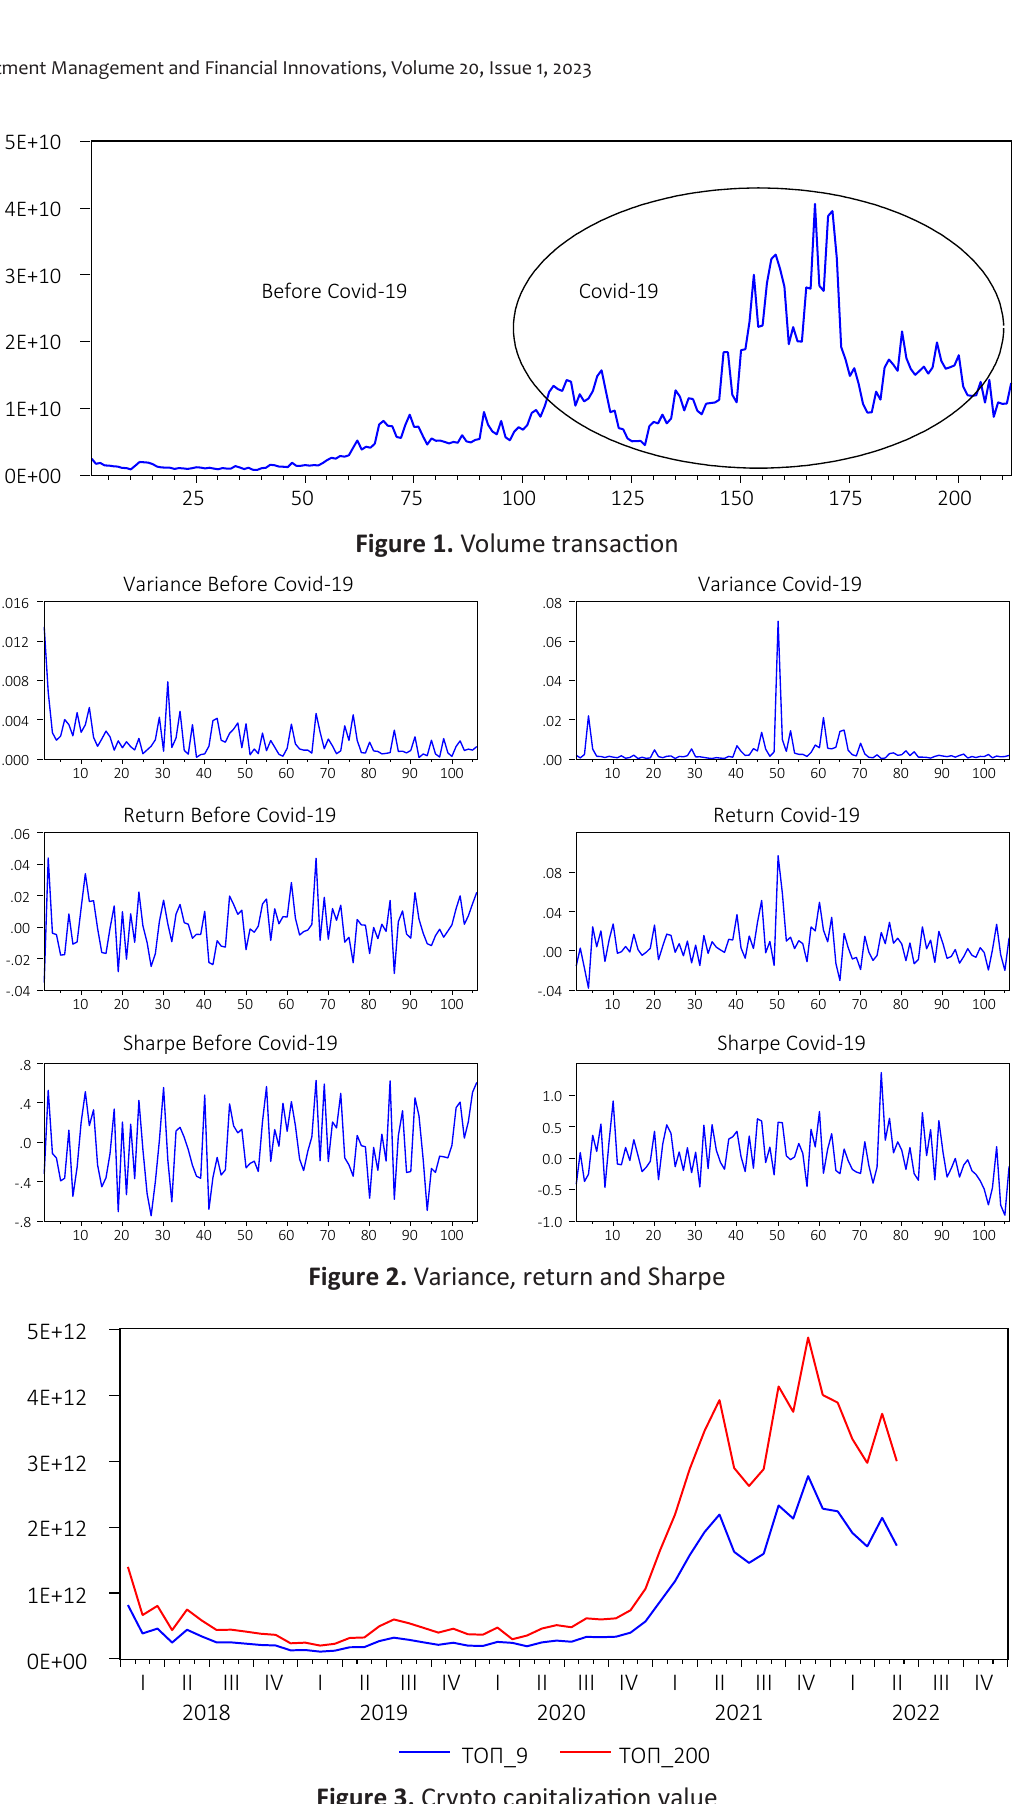
Figure 3. Crypto capitalization